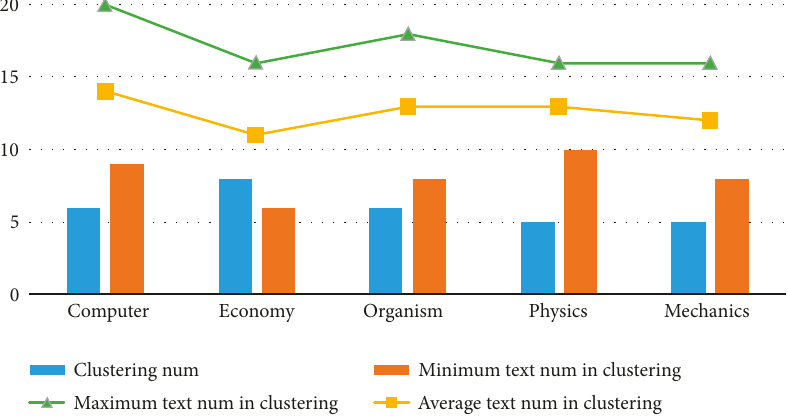
Figure 4: The feature statics and analysis of data set.